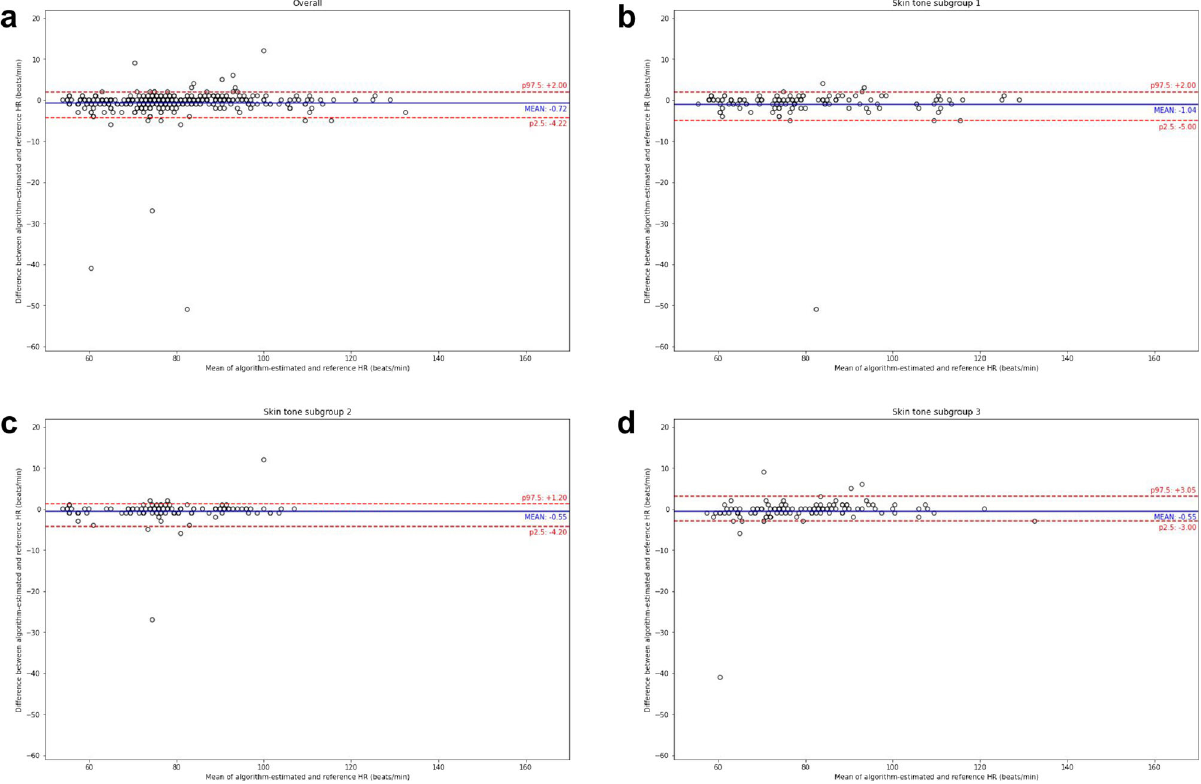
Fig. 2 Bland – Altman plots for the heart rate (HR) study. Plots from the full study ( a ) followed by subgroups based on skin type ( b – d ) ( n = 352 for all [ a ], 119 for subgroup 1 [ b ], 113 for subgroup 2 [ c ], and 120 for subgroup 3[ d ]). The reference HR was obtained from a pulse oximeter (see Methods). Dots represent individual participants; blue lines indicate the mean difference; red lines indicate the limits of agreement (based on the 2.5th and 97.5th